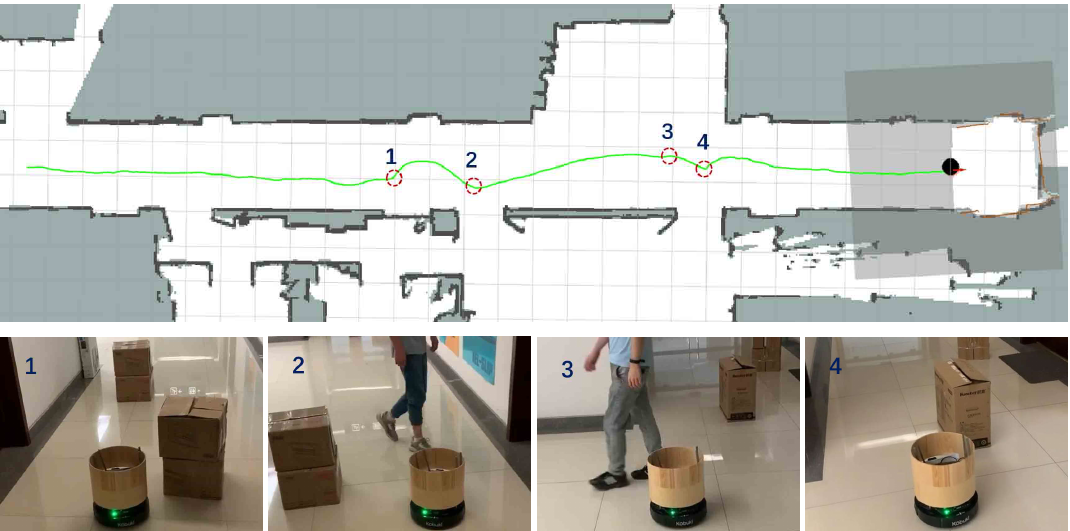
Figure 19. The long-range navigation scenario, where the navigation system with our DRL-based collision avoidance policy to go through the long corridor while avoiding static obstacles and dynamic pedestrians. The upper picture denotes the grid map of the entire environment map and the trajectory of the robot, and the square around the robot represents its egocentric local grip map. The lower pictures specify situations of the corresponding number in the real world when the robot is at the corresponding dotted circles in the